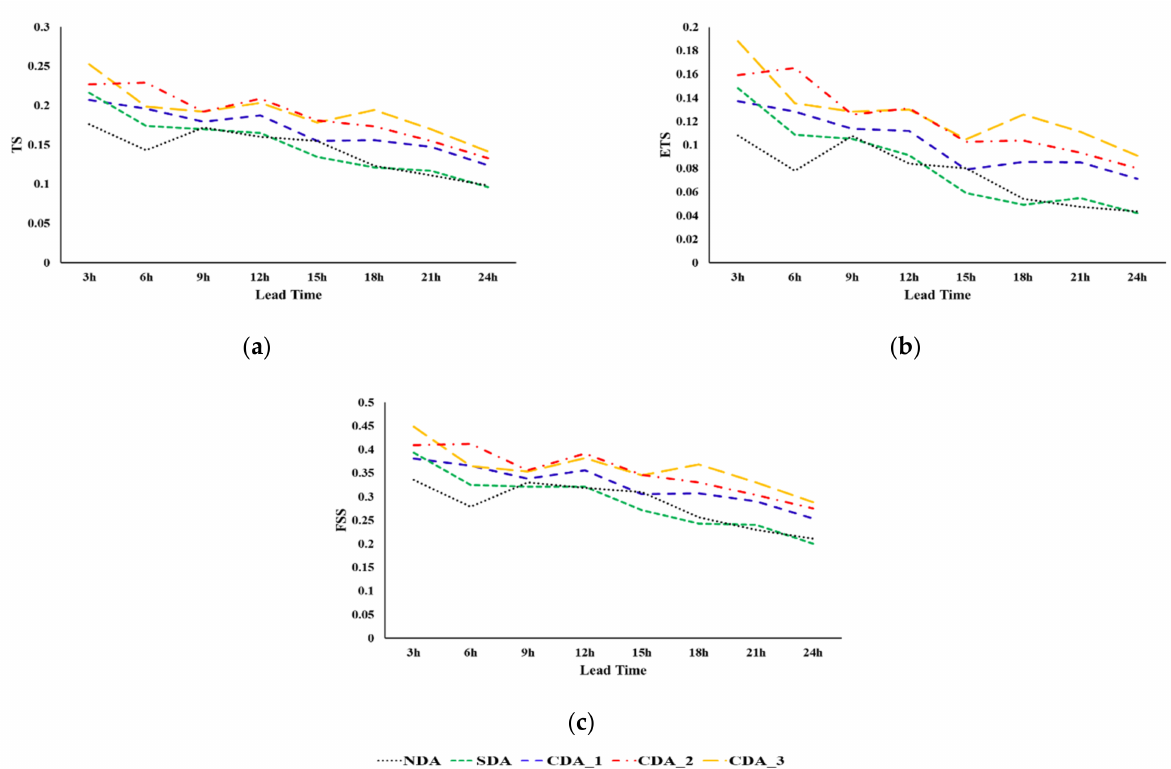
Figure 13. Rainfall forecast score as a function of forecast lead time for ( a ) threat score (TS), ( b ) equitable threat score (ETS), and ( c ) fraction skill score (FSS).